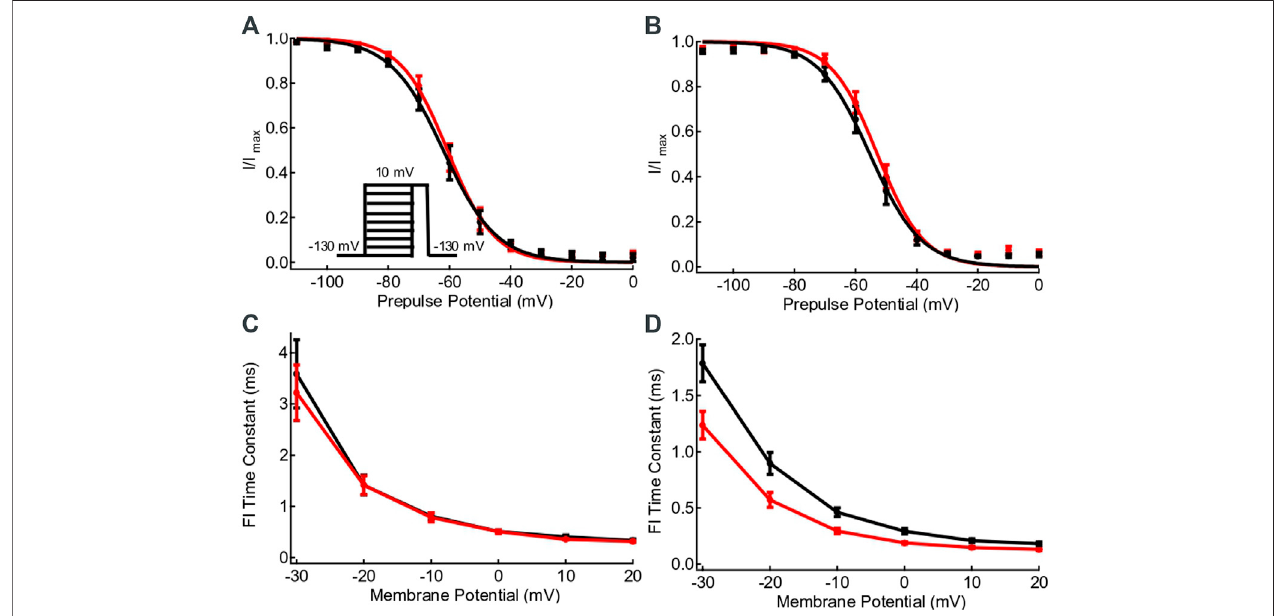
FIGURE3| L1624Qspeedstherateoffastinactivationonset. (A,B) :Voltage-dependenceofsteady-statefastinactivationinWT(black)andL1624Q(red)channels at 22 ° C ( A , n WT (cid:1) 9, n LQ (cid:1) 9) and 37 ° C ( (B) , n WT (cid:1) 8, n LQ (cid:1) 8). The inset shows the voltage-protocol used to measure steady-state inactivation. (C,D) : Fast inactivation onset time constants plotted against membrane potential at 22 ° C ( C , n WT (cid:1) 5, n LQ (cid:1) 8) and 37 ° C ( (D) , n WT (cid:1) 7, n LQ (cid:1) 8). All midpoint measurements are mean and error bars represent standard error of the mean.